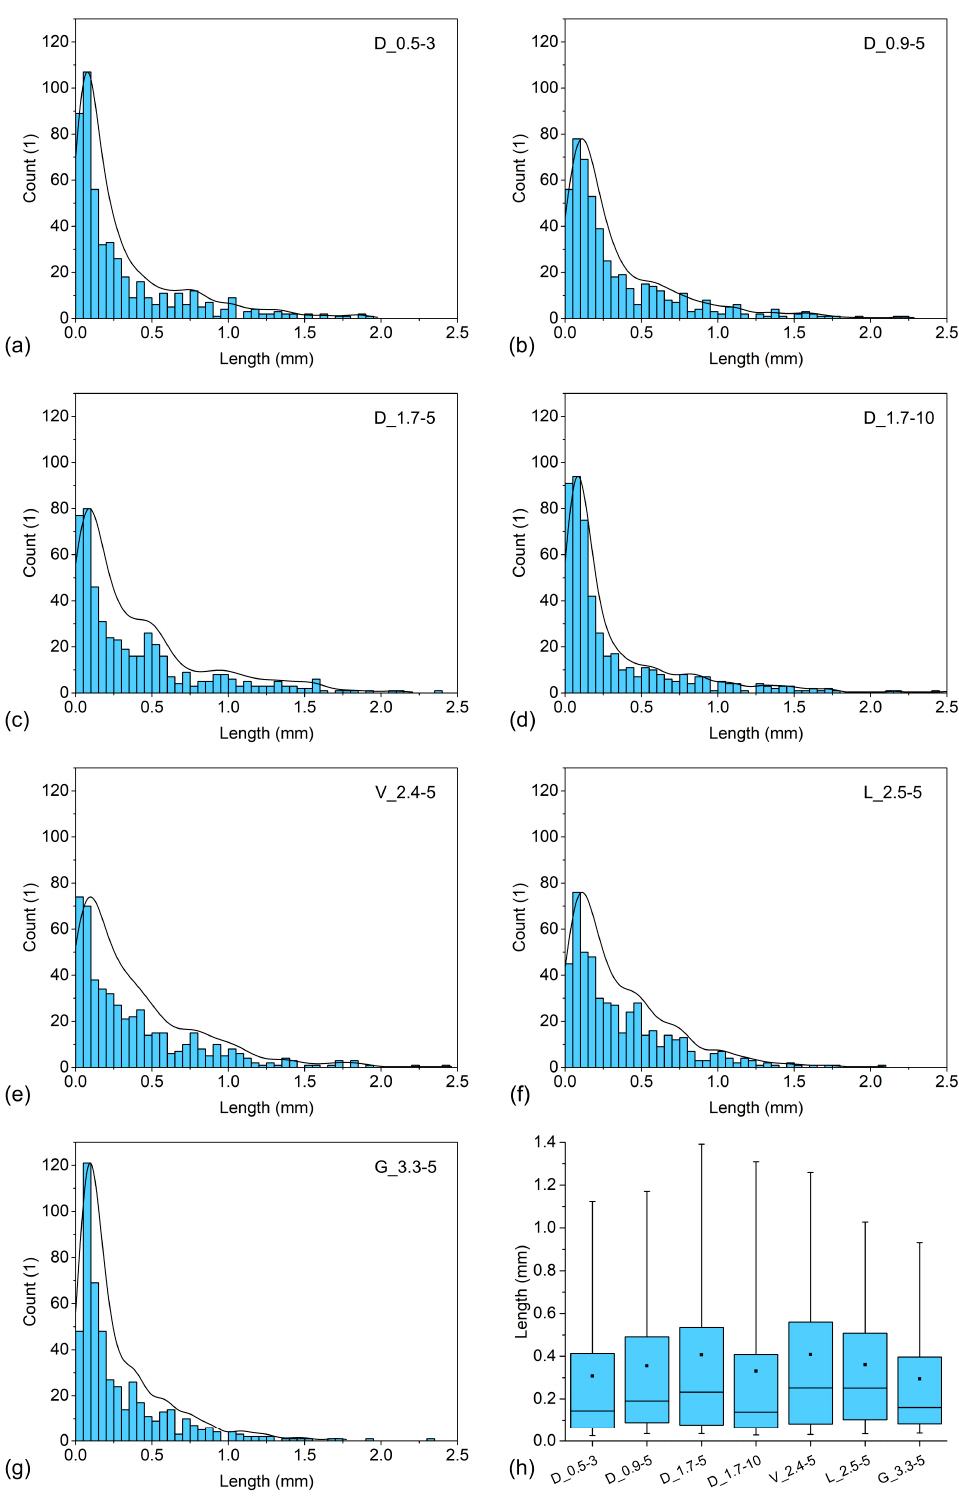
Figure 2. Fibre length distribution representations in Charpy impact test specimens of samples: ( a ) D_0.5 ‐ 3; ( b ) D_0.9 ‐ 5; ( c ) D_1.7 ‐ 5; ( d ) D_1.7 ‐ 10; ( e ) V_2.4 ‐ 5; ( f ) L_2.5 ‐ 5; ( g ) G_3.3 ‐ 5; and ( h ) comparison of all samples.